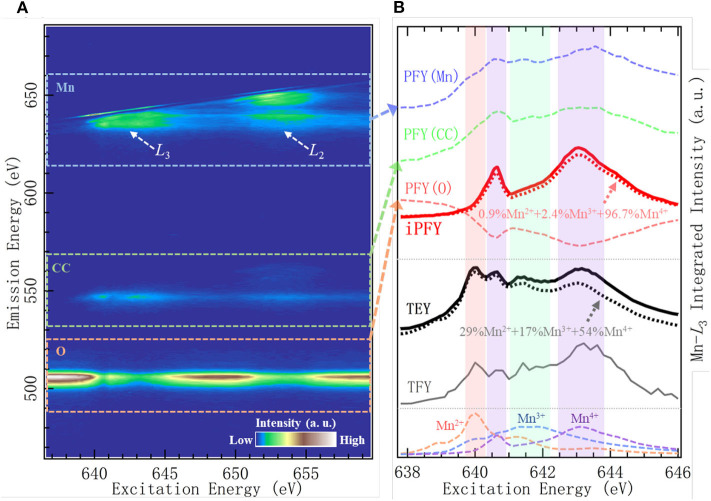
Mn-L mapping of resonant inelastic X-ray scattering (mRIXS) (A) and various absorption profiles (B) of Na0.6Li0.2Mn0.8O2. Reproduced from Wu et al. (2020b) with no permission required from authors.